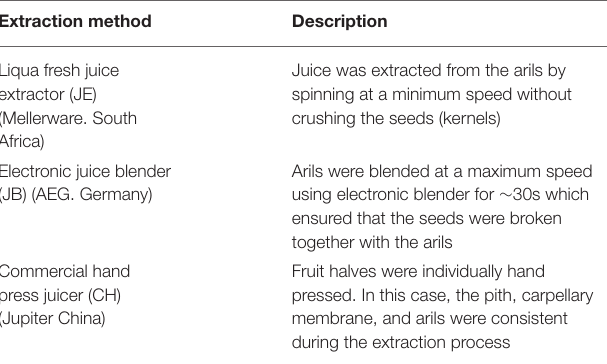
TABLE 1 | Extraction techniques and fruit fractions used to obtain juice from pomegranate fruit (cv. Wonderful). Extraction